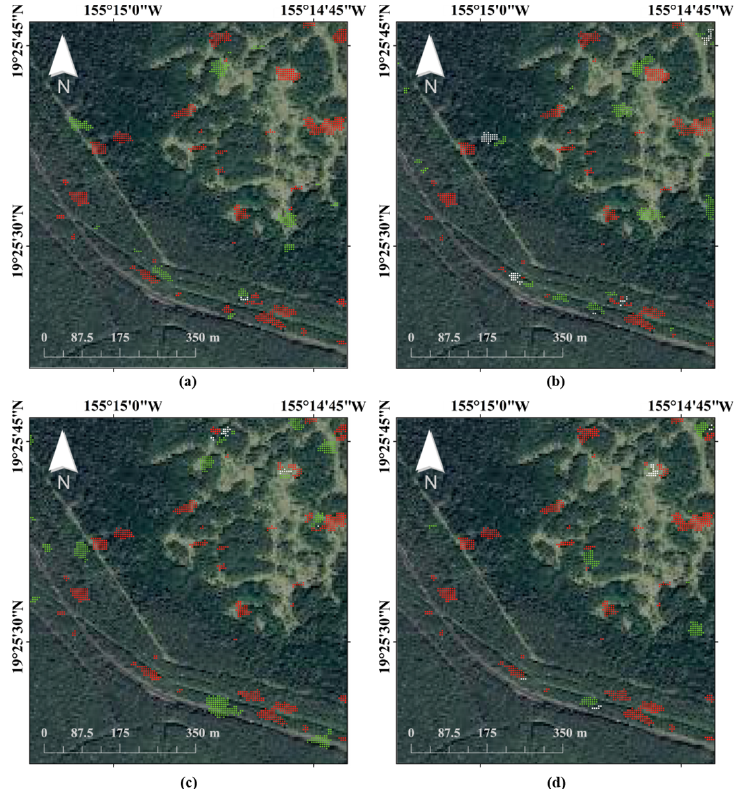
Figure 16. The local detail map of DSs: ( a ) comparison between OPT-1 and OPT-2; ( b ) comparison between OPT-1 and OPT-3; ( c ) comparison between OPT-1 and TraCoh; ( d ) comparison between OPT-1 and VV-VH. The red points represent the DSs of OPT-1, the green points represent the DSs of the other method (OPT-2/OPT-3/TraCoh/VV-VH), and the white points represent the common DSs.